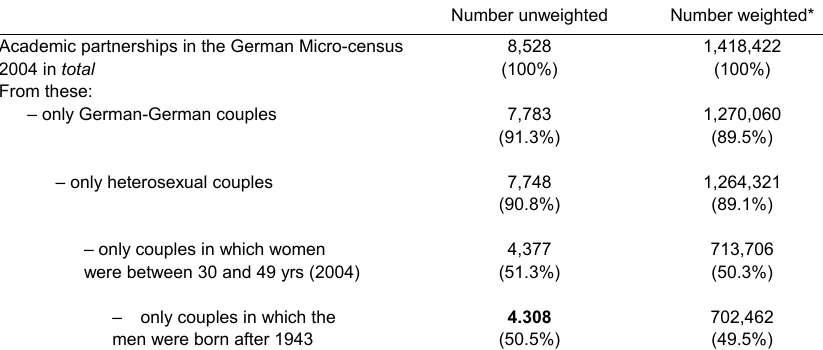
Table A1: Case selection from the German Micro-census 2004 Number unweighted Number